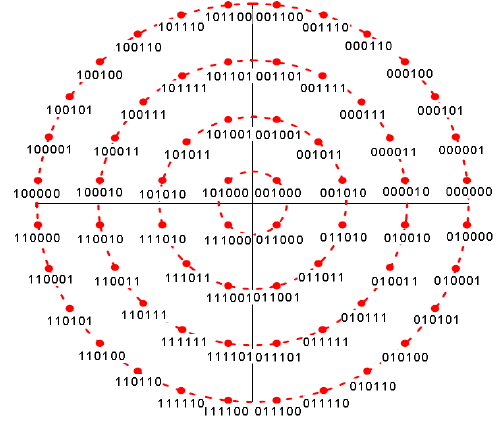
Figure 11. 64-APSK.